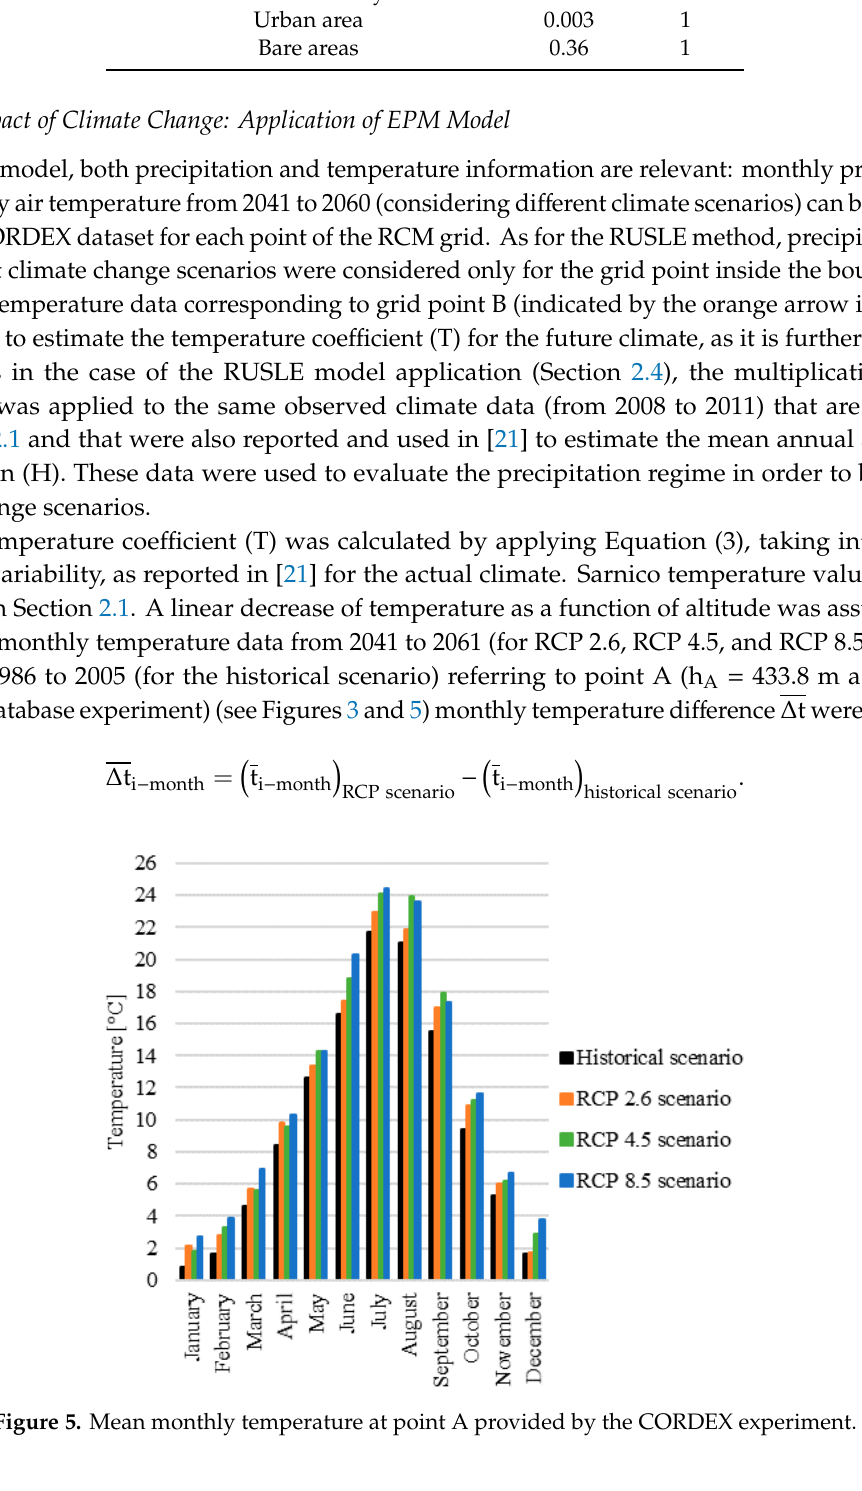
Table 4. C factor values and P factor values. C: cover-management factor, P: supporting practices factor. Land Use C Factor P Factor Wooded, reforested and forested area 0.002 1 Grassland 0.07